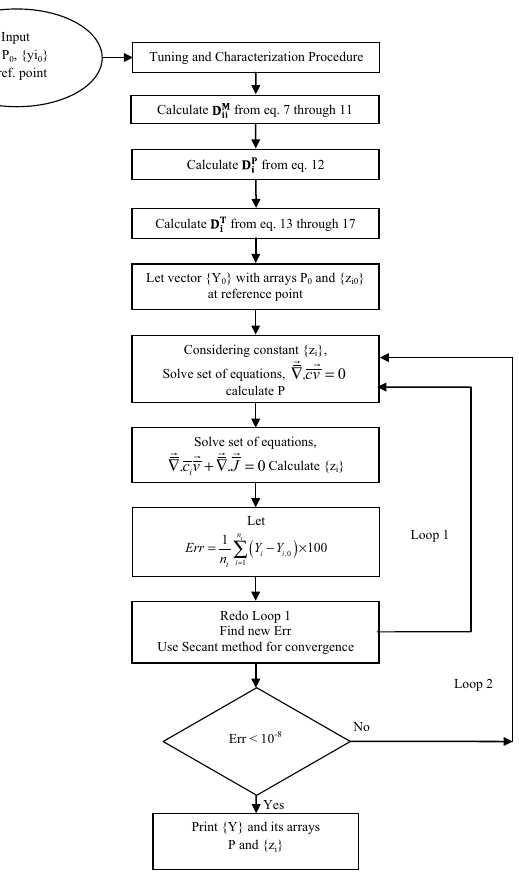
Fig. 2 Flowchart of numerical method